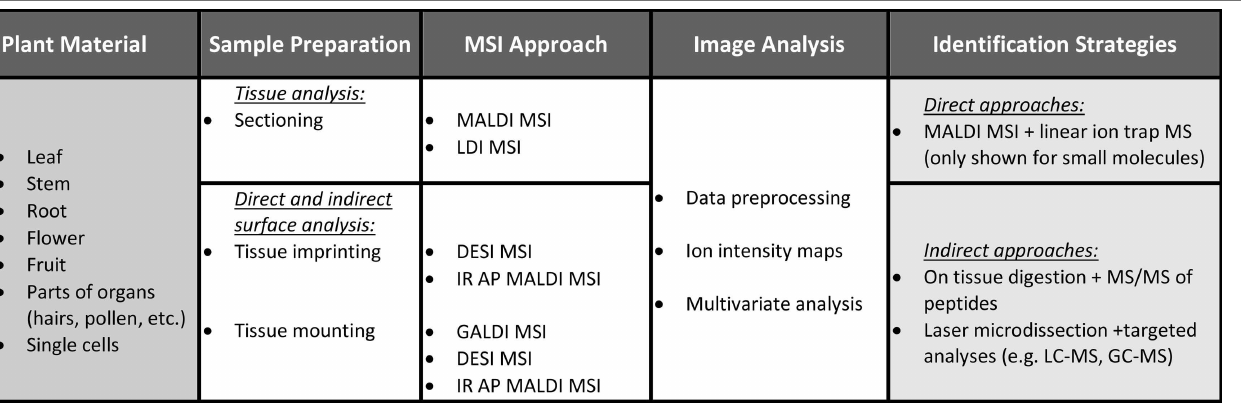
Table 2 | Schematic representation of the current status of MSI in plant science.